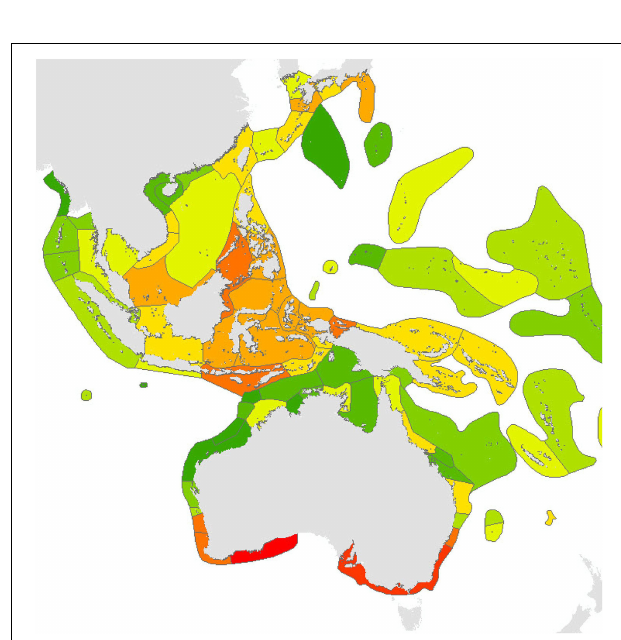
FIGURE 18 | Endemism Index of central Indo-Pacific ecoregions calculated by the methodology of Kier and Barthlott (2001) and Crisp et al. (2001). Deep red = highest levels of endemism intergrading to dark green indicating no endemism, see text. It should be noted that the four highest levels of endemism within the Coral Triangle may reflect the amount of fieldwork that these areas have